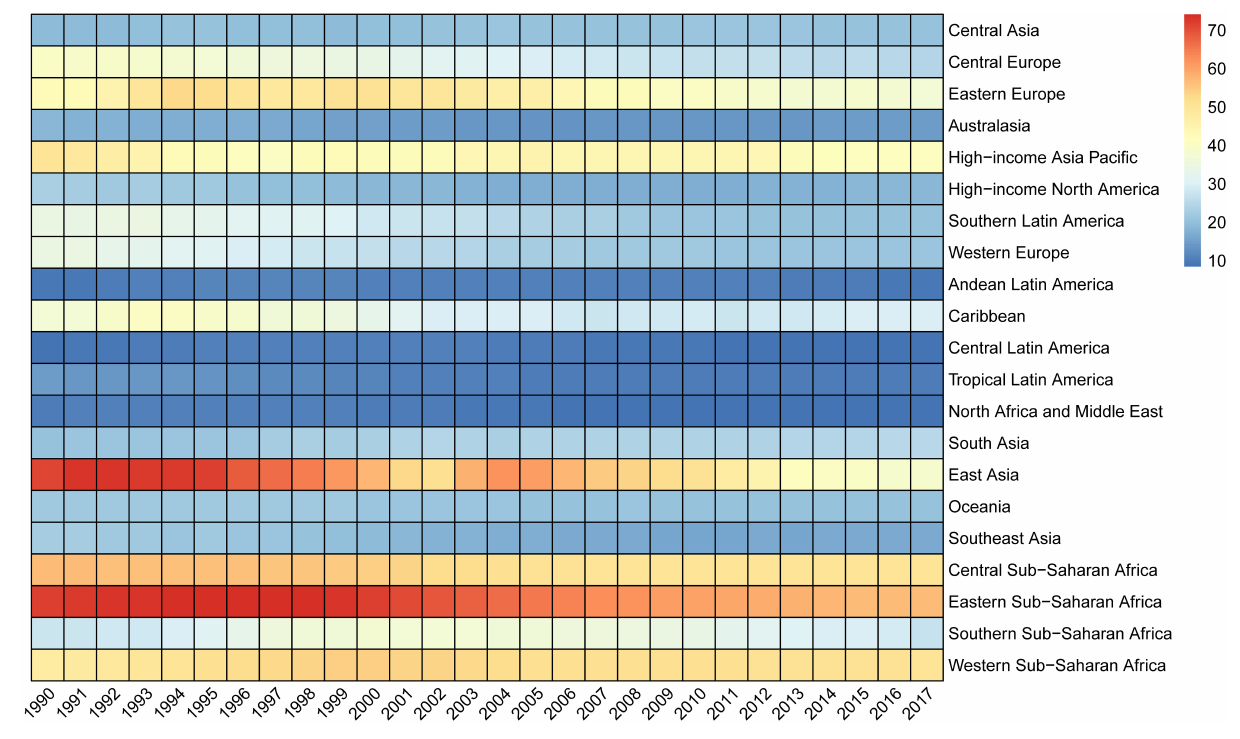
FIGURE 3 | Mortality rates per 100,000 from suicide for the elderly by GBD region, 1990 to 2017. GBD, Global Burden of